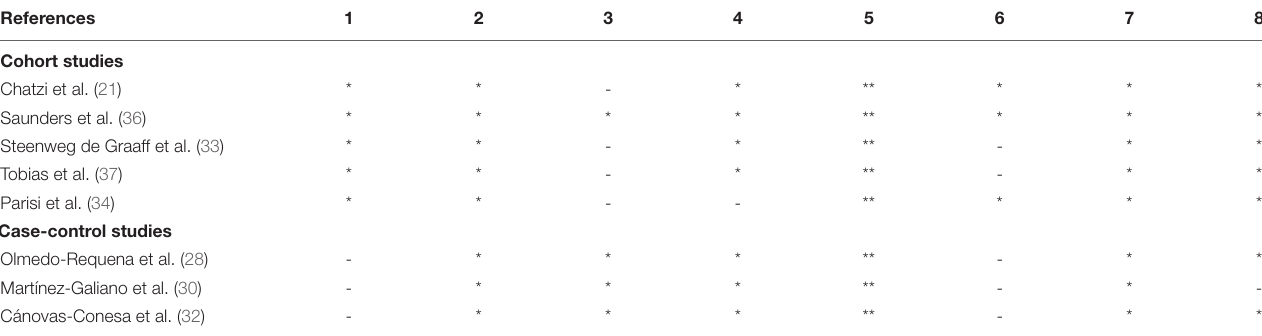
TABLE 4 | Tool questions Newcastle-Ottawa.